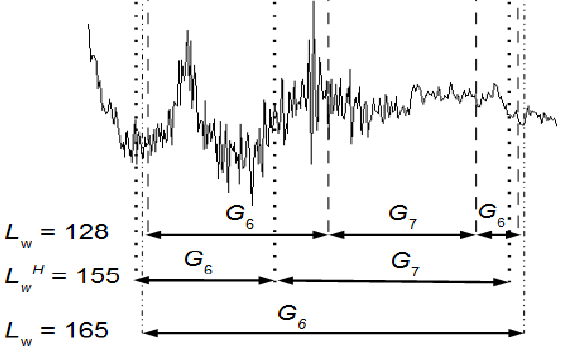
Figure 6. Events detected between the samples 46,389 and 46,653 using a L wH = 155, L w = 128 and